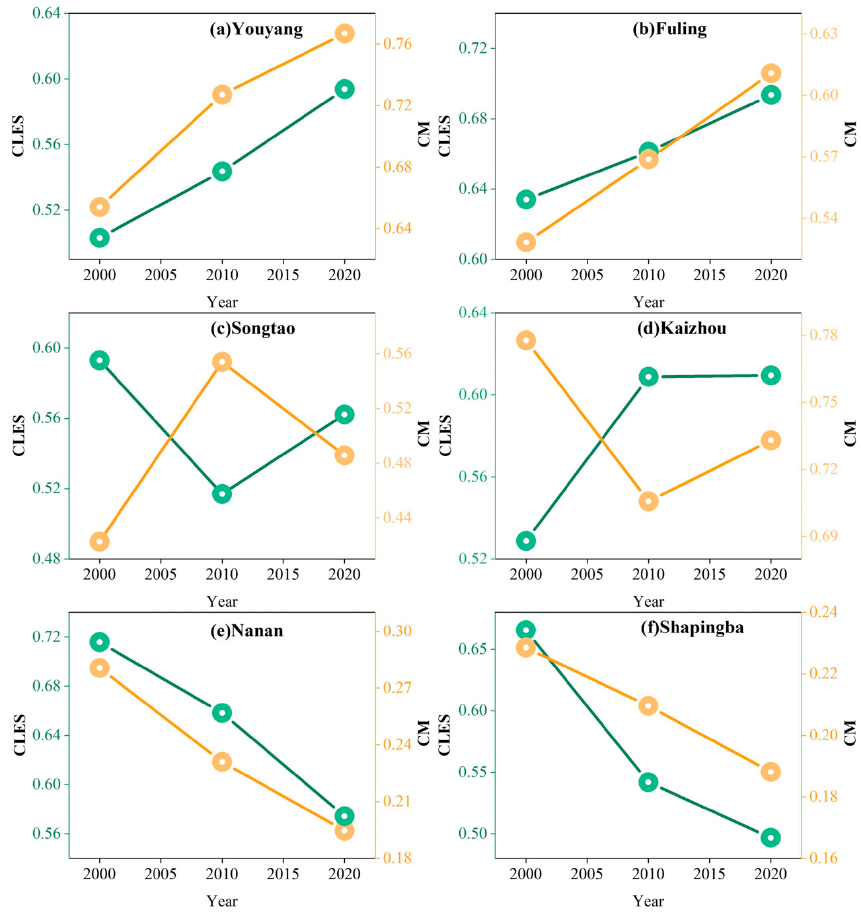
Figure 7. Multistage representation of CLES and CM evolution of multiple types: CLES: cropland landscape ecological security; CM: cropland multifunctionality.